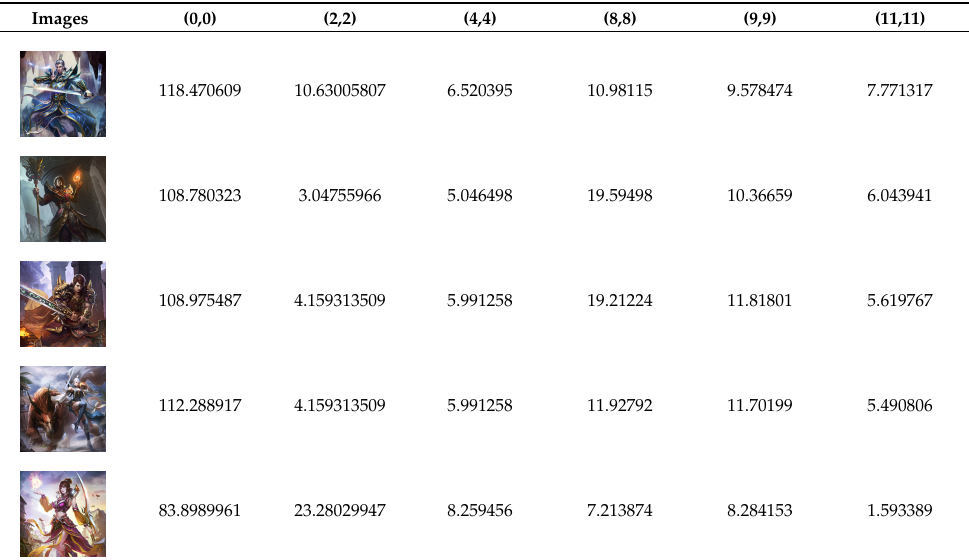
Table 6. The low-order pseudo-Zernike moments among different